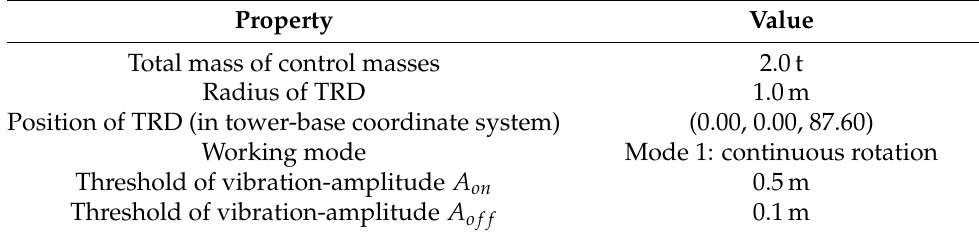
Table 1. Properties of TRD for NREL 5MW reference wind